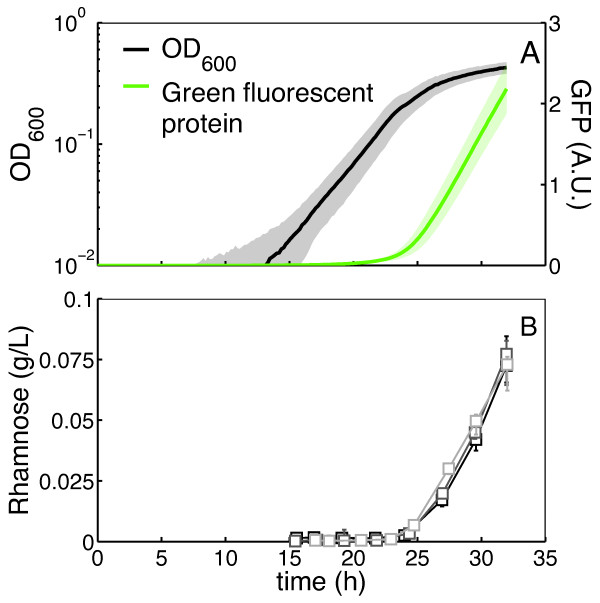
Average growth, GFP expression and rhamnose secretion in WT cells. A) Average growth of WT cells (black) with standard deviation (gray), inoculated at 0.0025 OD600 over three independent experiments. Average GFP expression (in arbitrary units), under the control of the PA01 rhlAB-promoter (green) with the standard deviation (light green) constructed from the same experiments. B) Time series of rhamnose secretion in WT from three independent experiments (grayscale squares). The time series were constructed using the calculated time-shifts from the respective experiments. For each rhamnose measurement, the median is plotted with the entire range of the measurements represented as error bars.